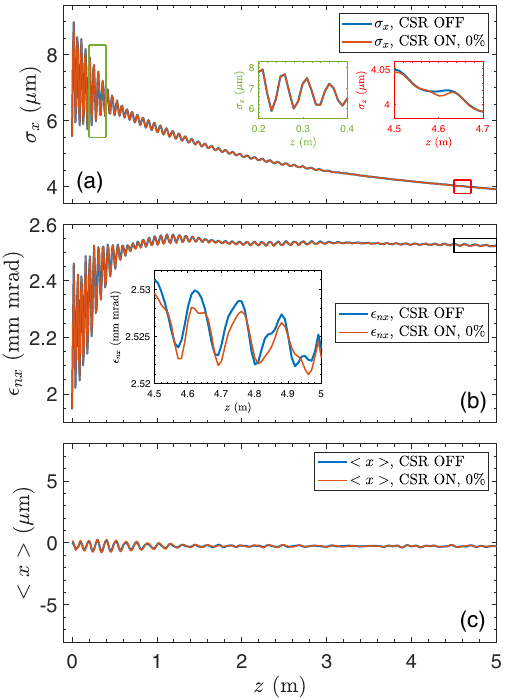
FIG. 21. Plots of (a) RMS beam envelope, (b) normalized emittance, and (c) horizontal beam centroid along the plasma source. CSR OFF is the case in which the CSR effect is not considered along the transfer line, and CSR ON is the case in which the CSR effect is considered. In the figure legends, 0% represents zero emittance growth driven by the CSR effect. Inserts are zoomed plots for the boxed regions.